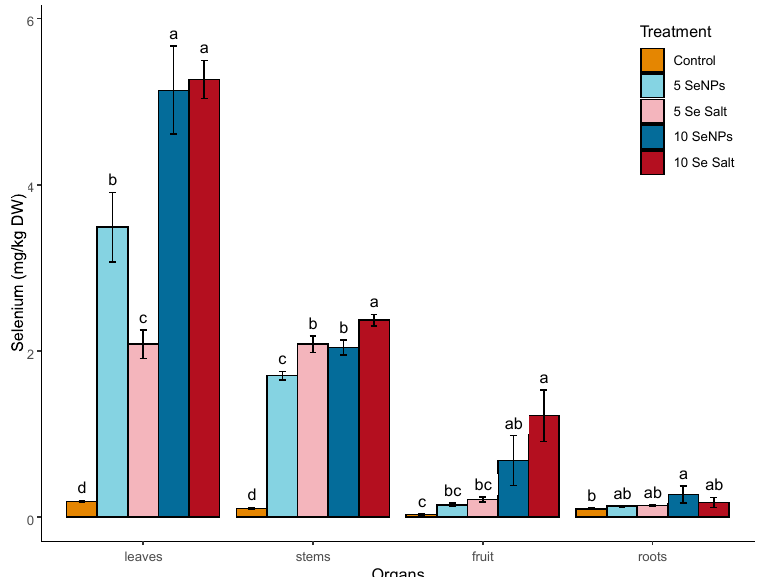
Figure 2. Total Se content in leaves, stems, fruit, and roots of tomato plants (cv. Micro-Tom) treated 2 months after transplanting with 0, 5, and 10 mg Se L − 1 as Se nanoparticles (SeNPs) and sodium selenate (Se Salt). Samples were collected 53 DAT. Bars indicate standard error. Letters indicate the results of the LSD test run separately for each organ. Values with the same letter are not statistically different ( p ≤ 0.05; n = 4).